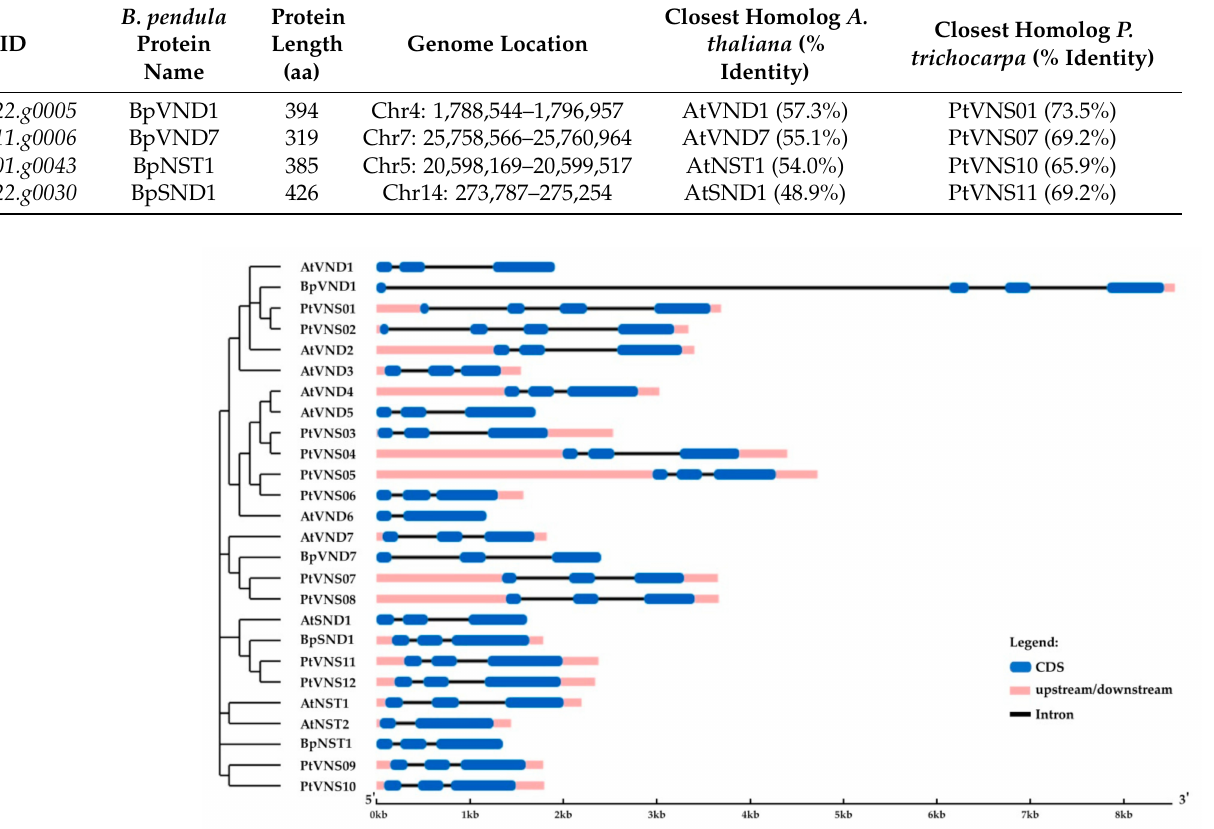
Figure 7. Structure of B. pendula , A. thaliana and P. trichocarpa VND and NST genes. Intron, exon, and untranslated regions (UTR) are represented by black lines, dark blue boxes, and pink